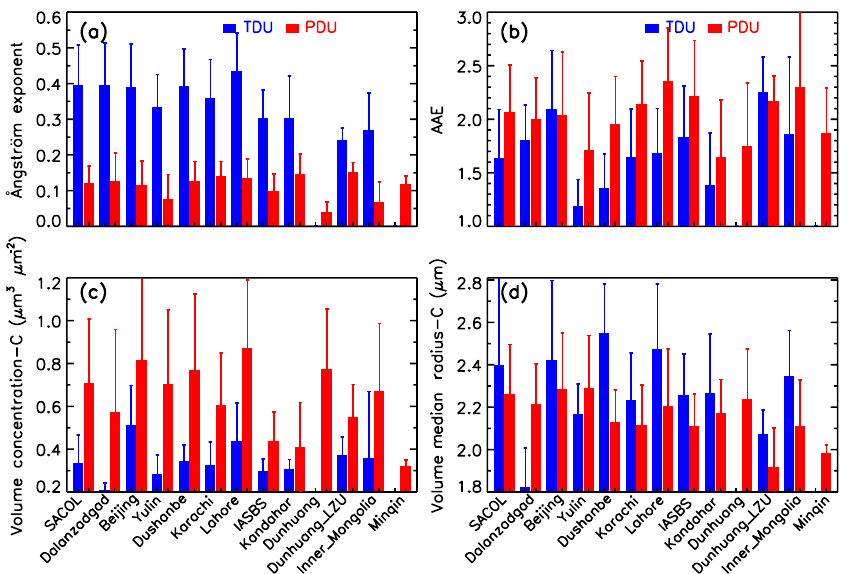
Figure 6. Total average values of (a) Ångström exponent (440–870nm), (b) absorption Ångström exponent (AAE) at 440–870nm, (c) volume concentration of coarse mode (µm 3 µm − 2 ) , and (d) volume median radius of coarse mode in µm for Transported Anthropogenic Dust (0.2< α <0.6, blue color) and Pure Dust ( α <0.2, red color) at 13 selected AERONET sites. The error bars indicate plus or minus one standard